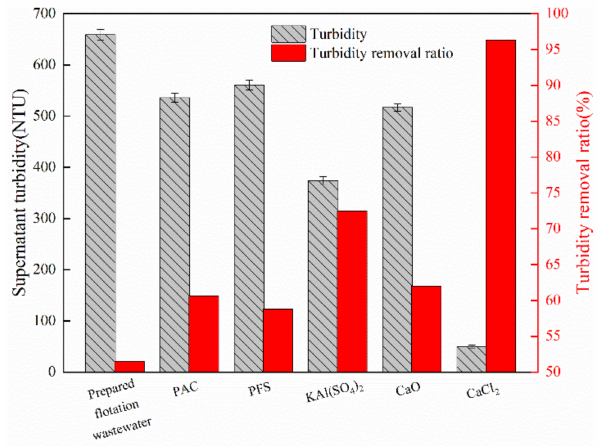
Figure 4. Treatment effect of different coagulants on the prepared flotation wastewater.